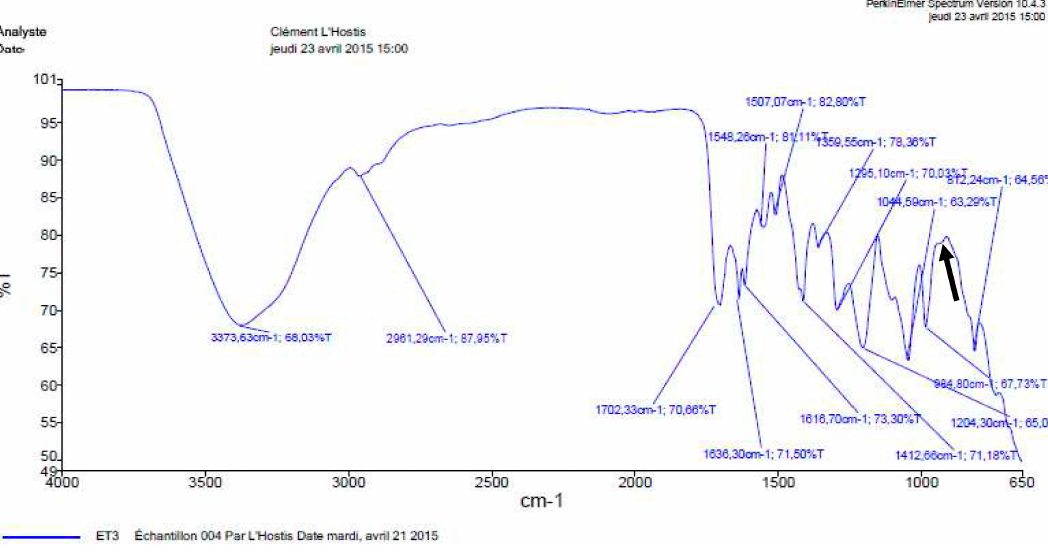
Figure 2. FTIR spectrum of the ET3 tannin epoxy acrylic resin sample.